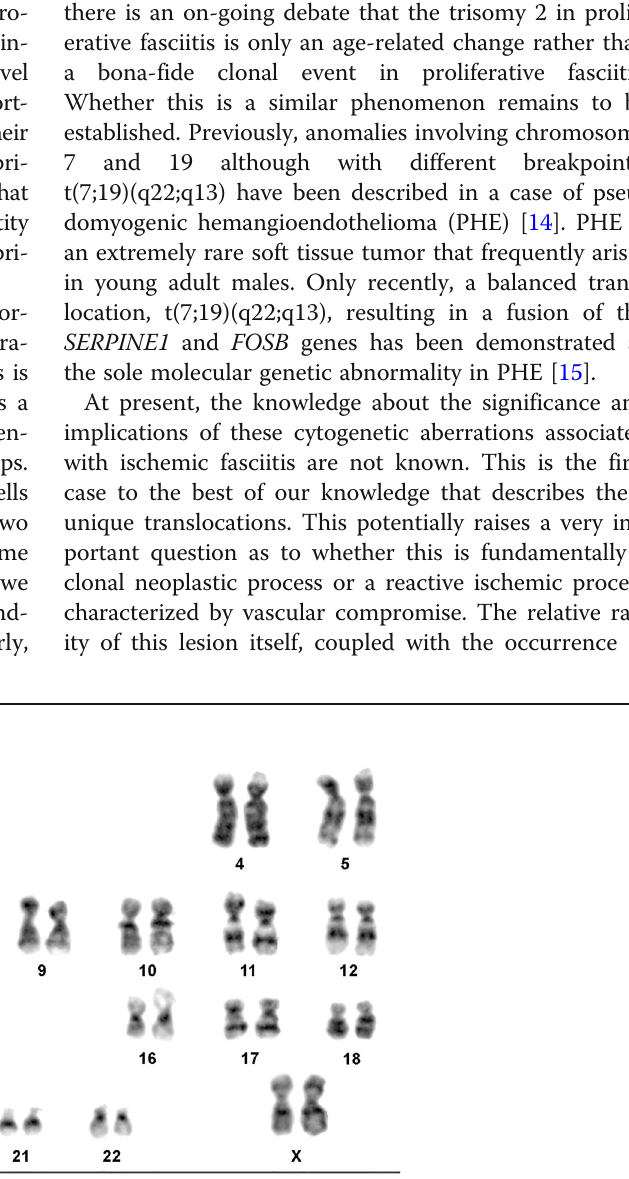
Fig. 3 G-Banded Karyotype showing 46,XX,t(1;2)(p36.1;q23),t(7;19)(q32;q13.3). Arrows indicate breakpoints